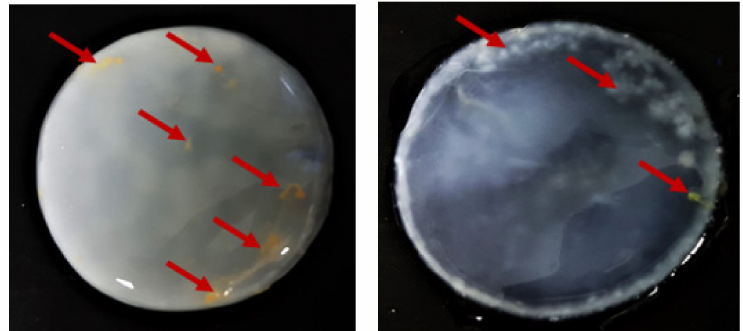
Figure 7. Purified BC from K. xylinus ATCC 53524 synthesized using natural (fruit) ingredients-based media. Red arrows indicate residues fragments (hard-to-remove impurities) of fruits bound in the BC membrane.